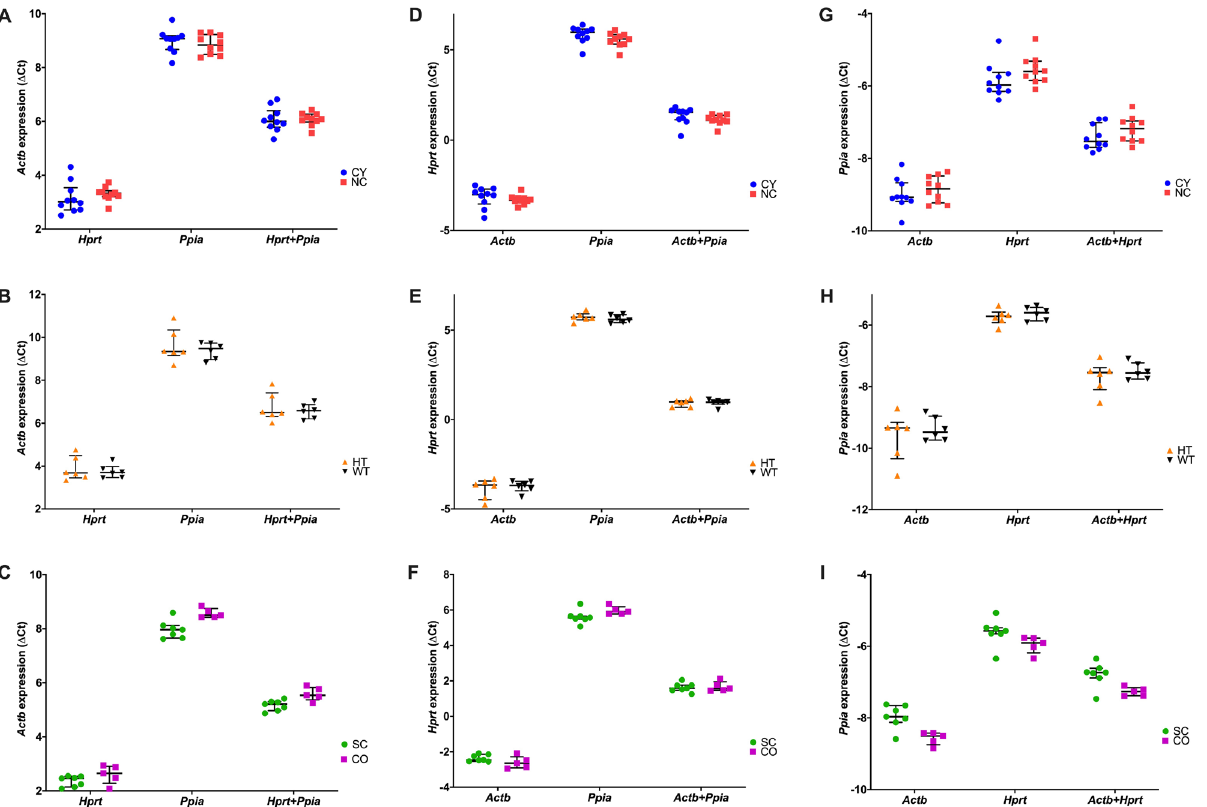
Figure 4. The ΔCt values of the three best candidate housekeeping genes: Actb ( A–C ), Hprt ( D–F ) and Ppia ( G–I ). A lower threshold value (Ct) indicates a higher gene expression level. The median values are expressed as horizontal lines while the error bars represent interquartile ranges. CY, cystic; NC, noncystic; HT, haploinsufficient; WT, wild type; SC, severely cystic phenotype; CO, control of severely cystic phenotype. Actb , target expression normalized by Actb ; Hprt , target expression normalized by Hprt ; Ppia , target expression normalized by Ppia ; Actb + Hprt , target expression normalized by Actb + Hprt ; Actb + Ppia , target expression normalized by Actb + Ppia ; Hprt + Ppia , target expression normalized by Hprt + Ppia . Comparisons between the Pkd1 -deficient model and its respective control were performed with the Mann–Whitney U test. P < 0.05 was not detected for any of the